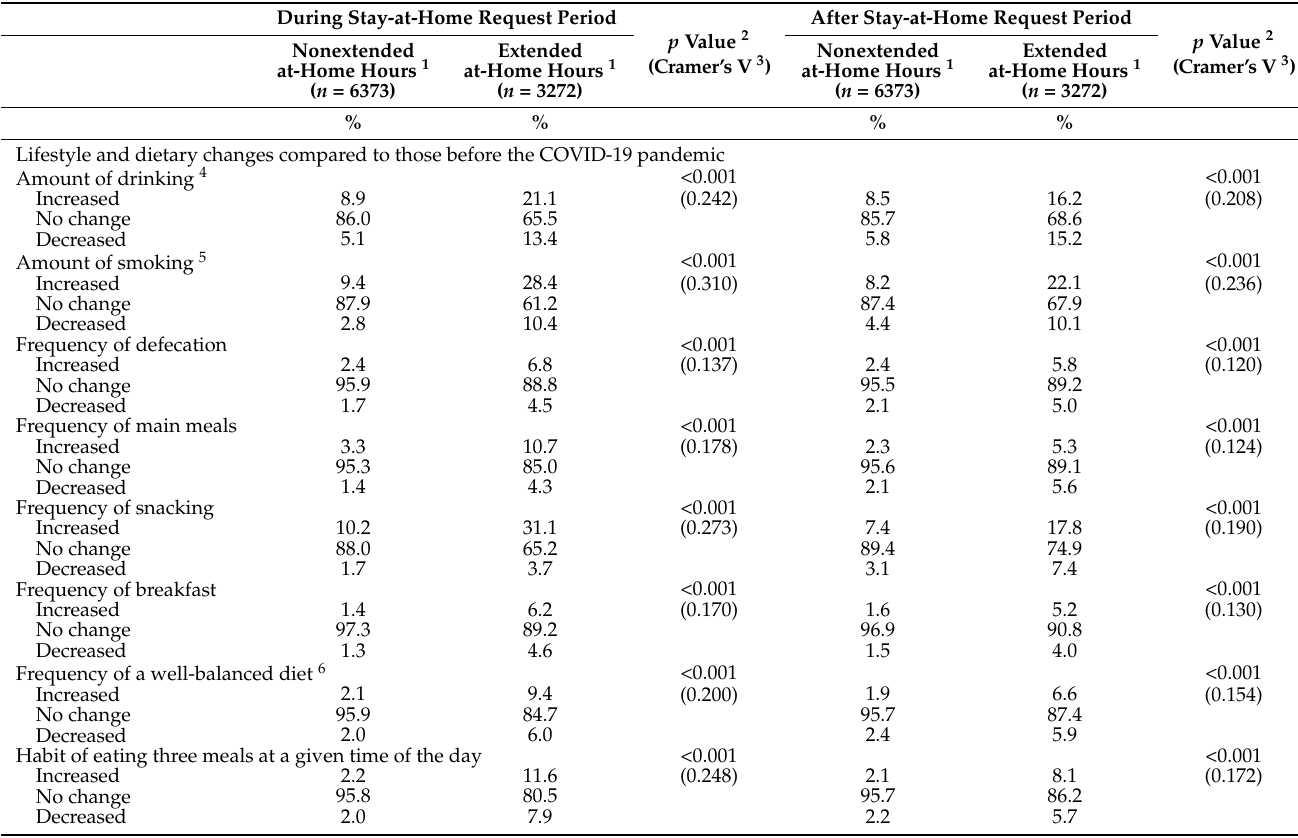
Table 4. Lifestyle and dietary habits during and after stay-at-home request period according to the changes in at-home hours during the stay-at-home request